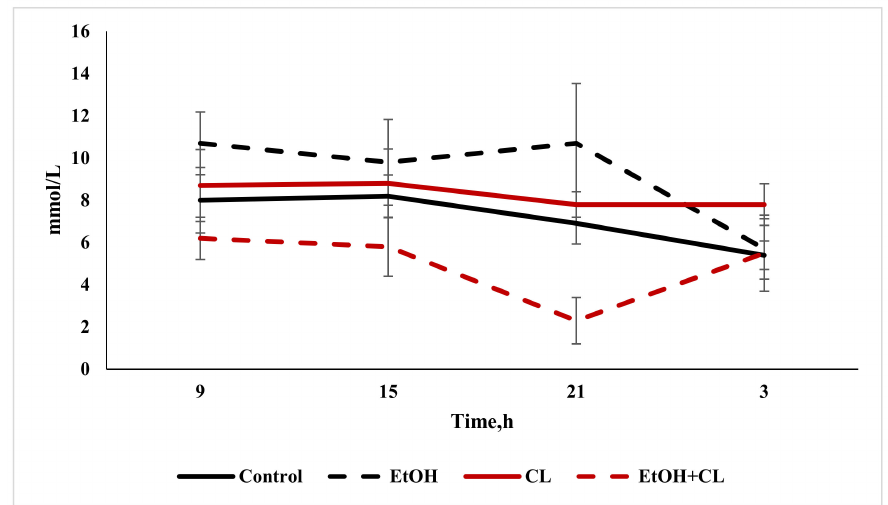
Figure 10. Daily fluctuations in blood glucose of rats.